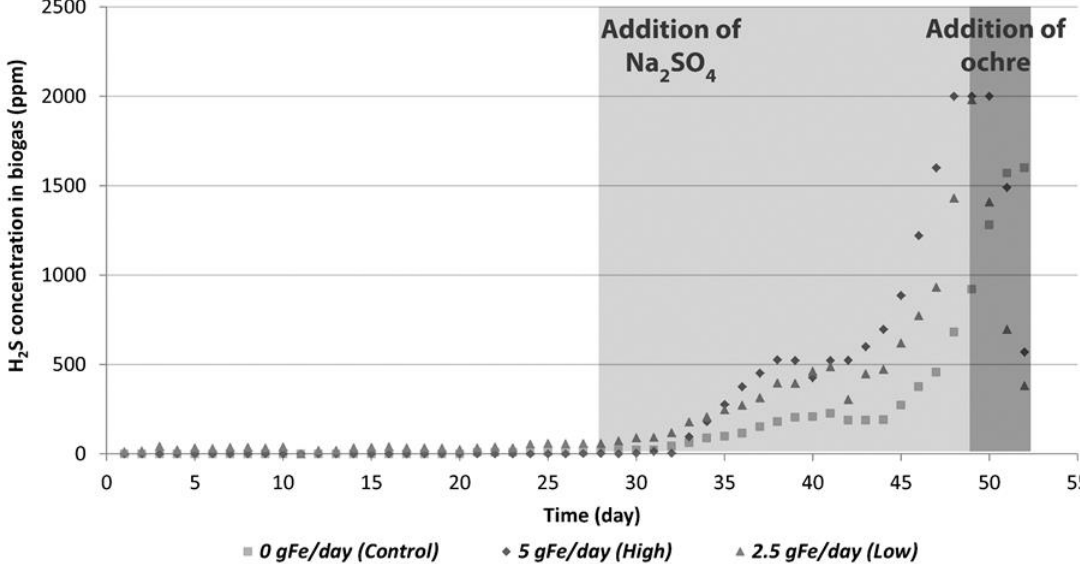
Figure 4. The hydrogen sulfide concentration in the produced biogas. Sodium sulfate started to be added in the reactors on day 28 of the experiment in order to provide sulfate as the substrate for the sulfate-reducing bacteria. The dosing of ochre started on day 49 in high (5 g Fe 3+ /day) and low (2.5 g Fe 3+ /day) reactors. No ochre was introduced in the control reactor.